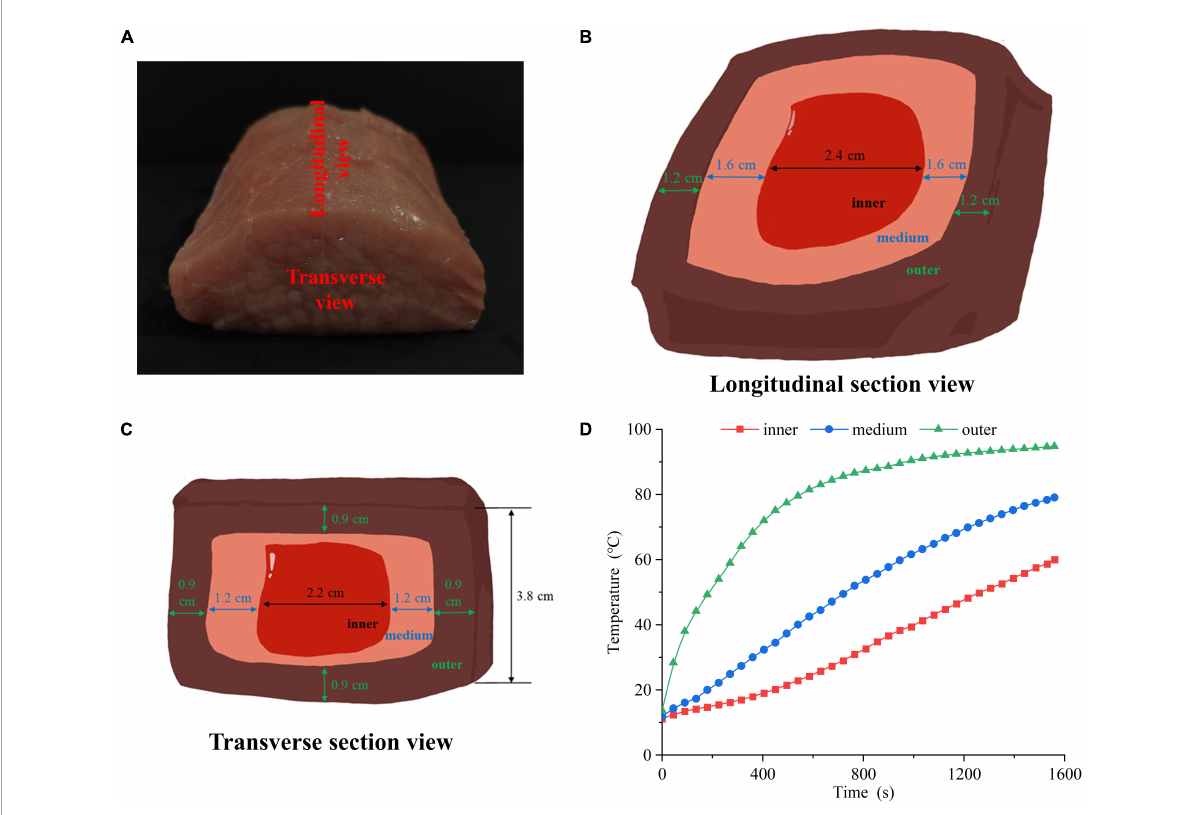
FIGURE1 (A) Physical picture of cutting the pork longissimus dorsi muscle. The (B) longitudinal section view, (C) transverse section view and (D) heating time curves of pork samples in different doneness